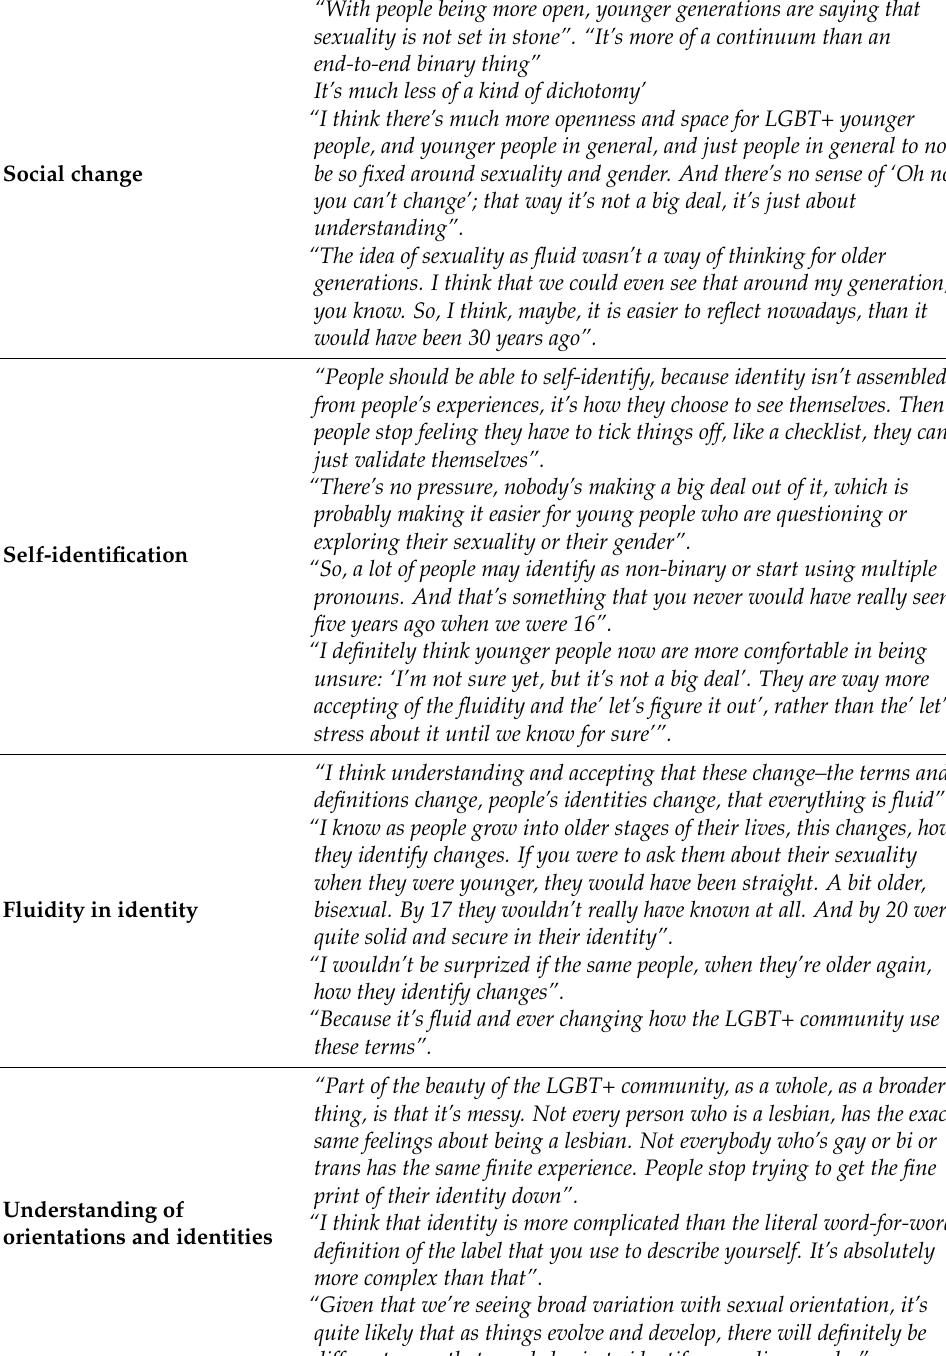
Table 4. Youth co-authors reflections on the representations of orientations and identities. Representations of Orientations and